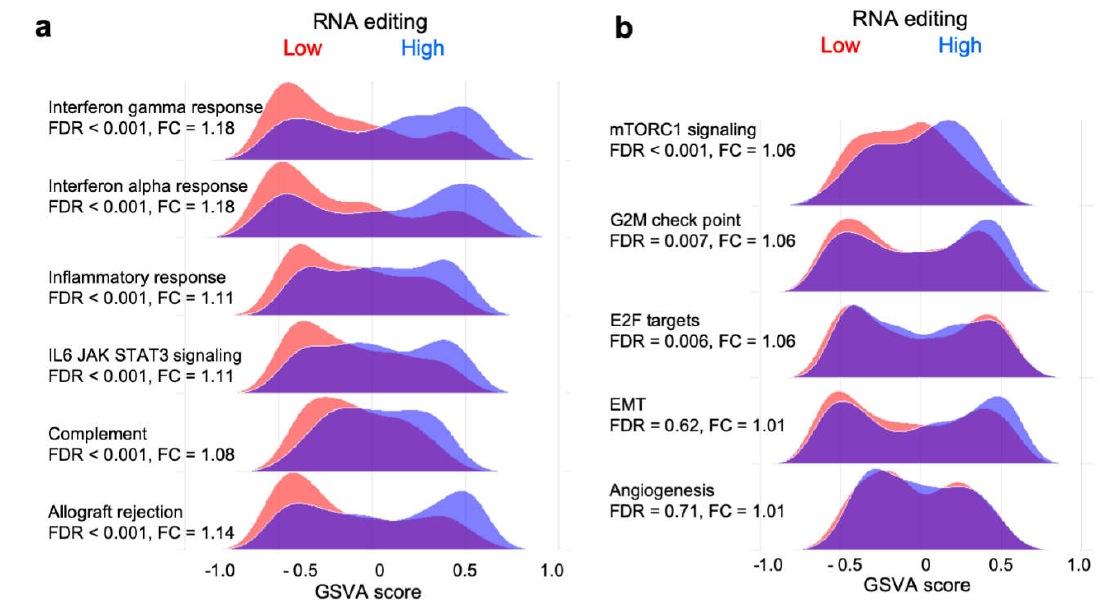
Figure 4. Immune-related gene sets have enriched expression in RNA editing-high tumors. Shown are examples of ridgeline plots of gene set variation analysis (GSVA) scores of RNA editing-high and -low tumors for ( a ) six immune-related gene sets and ( b ) five other gene sets of Molecular Signatures Database (MSigDB) Hallmark collection. Fold change (FC) values comparing scores of editing-high and -low tumors and false discovery rate (FDR) values in significance analysis of the comparisons were calculated with a Bayes-moderated t -test. EMT, epithelial mesenchymal transition.